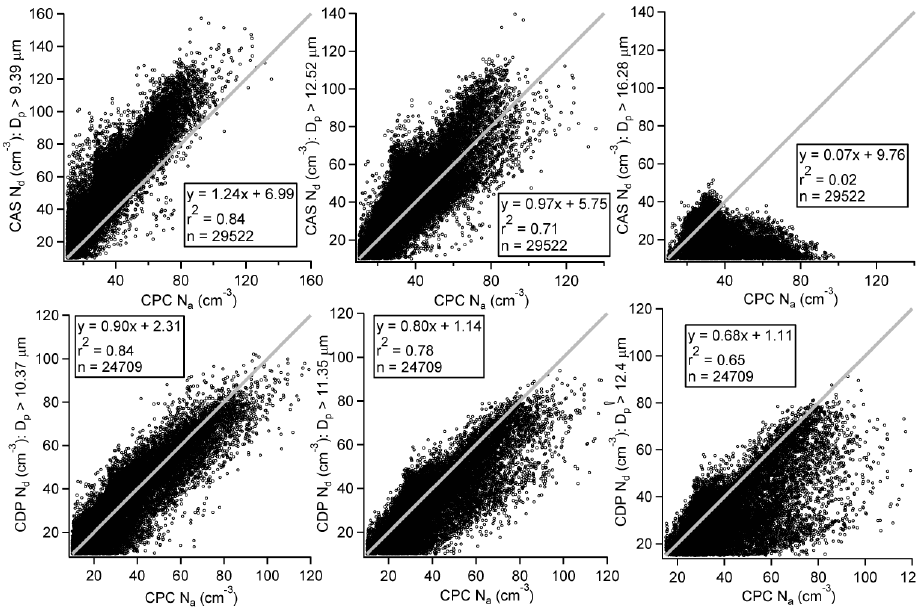
Fig. 6. Comparison of corrected total particle concentration ( N a ) measured behind the CVI by a CPC and total cloud drop concentration ( N d ) measured by two independent cloud probes (CDP and CAS). For both cloud probes, N d is reported above three different minimum drop sizes around the expected cut size ( ∼ 11µm) of the CVI at 50m s − 1 for the usual add-flow rate applied ( ∼ 16lmin − 1 ) based on wind tunnel results. Data are shown when the in-cloud liquid water content exceeded 0.05gm − 3 , when the aircraft speed was between 45–60ms − 1 , and when the add-flow rate was between 16–17lmin − 1 . The gray shaded lines signify the 1-to-1 line. The reason the slope of the top right panel is much lower than the rest is that the majority of the sampled cloud drop number concentrations were typically at lower